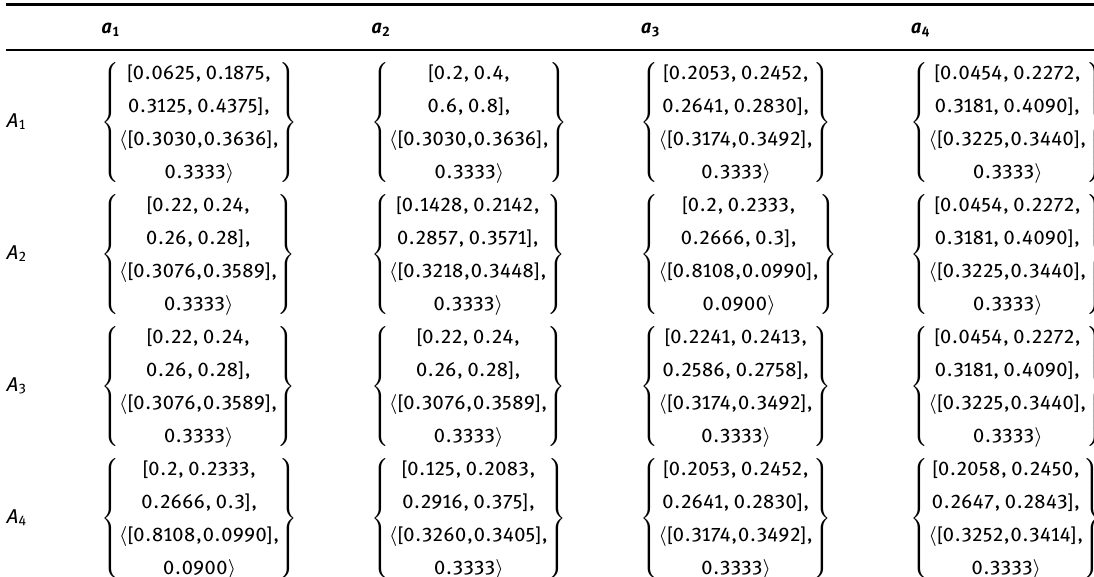
Table 6: Normalized Decision Matrix Given by Expert p 3